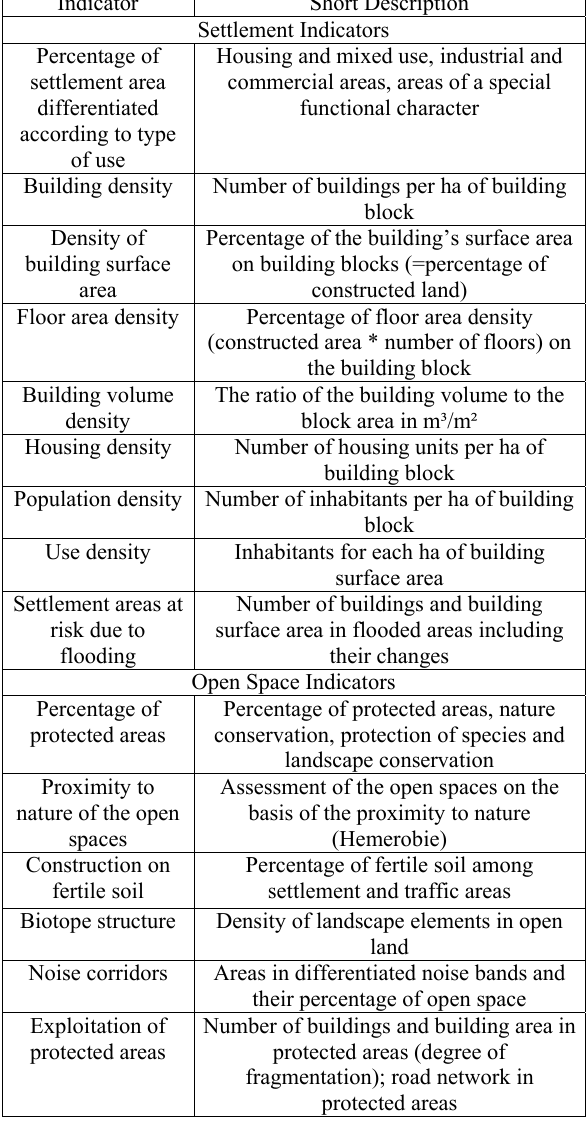
Table 2. Selected indicators of the Monitor of settlement and open space development